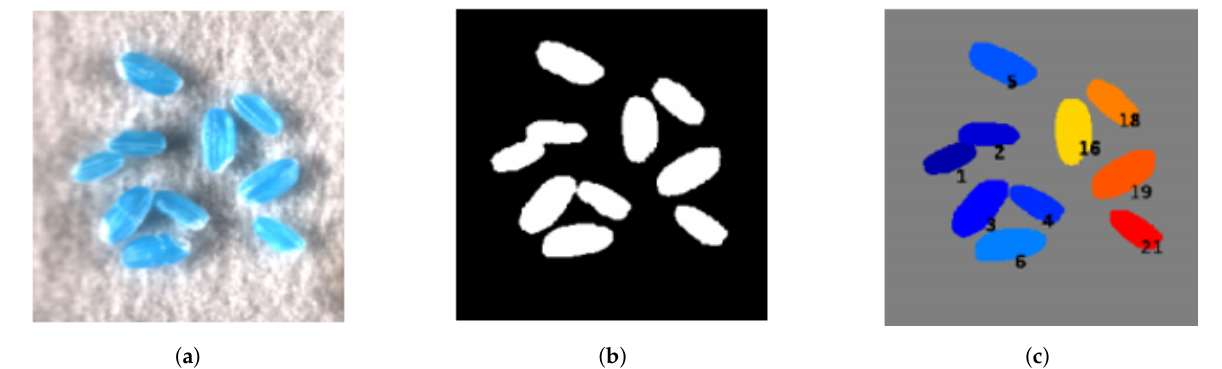
Figure 4. Seed segmentation: ( a ) the raw hyperspectral image of rice seeds; ( b ) the initial segmentation results showing overlapping region of seeds; ( c ) the refined segmentation results clearly defining seed